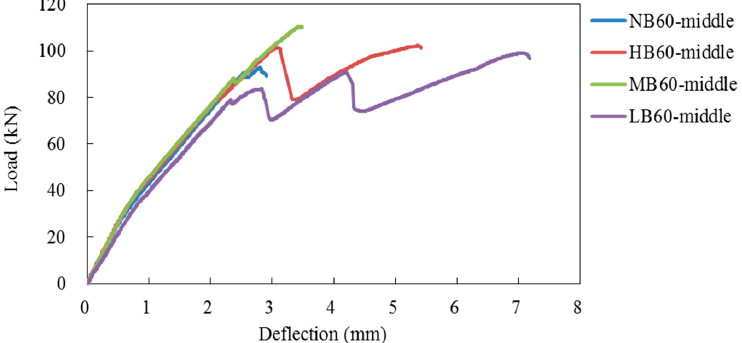
Figure 18. Load-deflection relationship for the large RC beams.